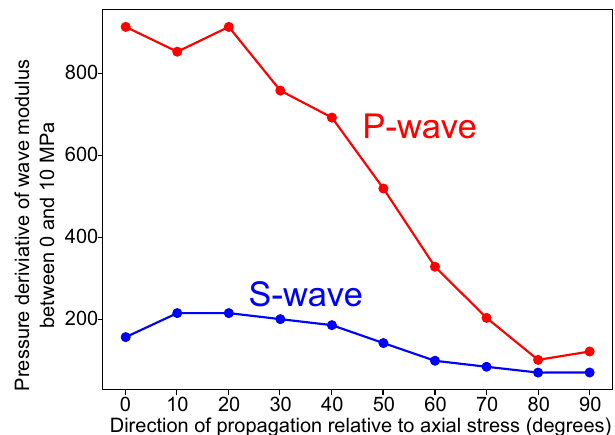
Fig. 1 Stress-induced anisotropy. Stress-induced anisotropy in nonlinear susceptibility with data from Nur and Simmons 42 . The vertical axis represents nonlinear susceptibility. The horizontal axis shows the angle between the orientation of the uniaxial stress and the orientation of propagation of the probe